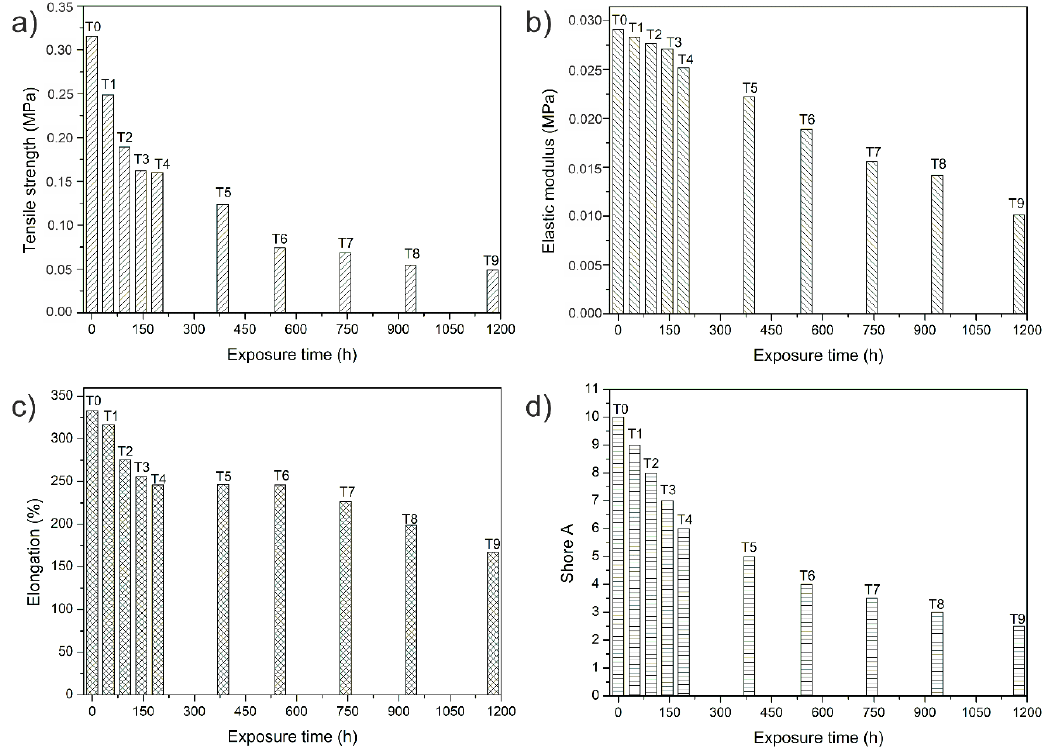
Figure 5. Mechanical properties versus UV exposures time of SEBS: ( a ) tensile strength, ( b ) elastic modulus, ( c ) elongation at break, and ( d ) hardness Shore A.